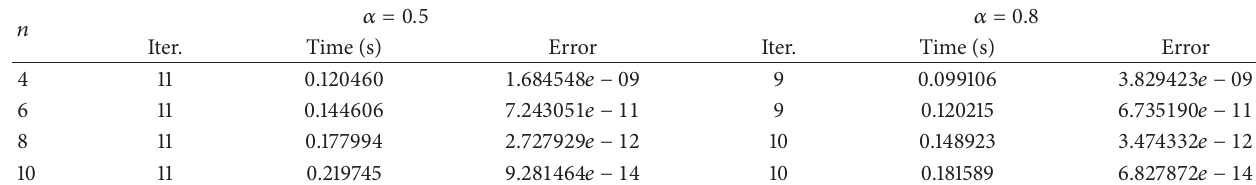
Table 1: The performance of spectral deferred correction method for solving Example 1.